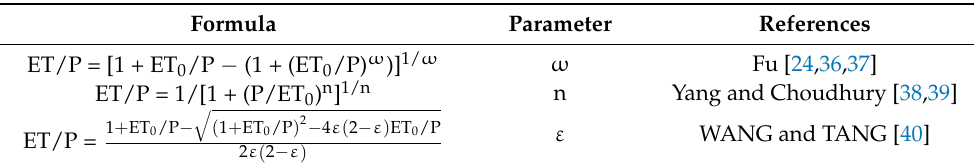
Table 1. Three Budyko-type equations for estimating actual evapotranspiration employed in this